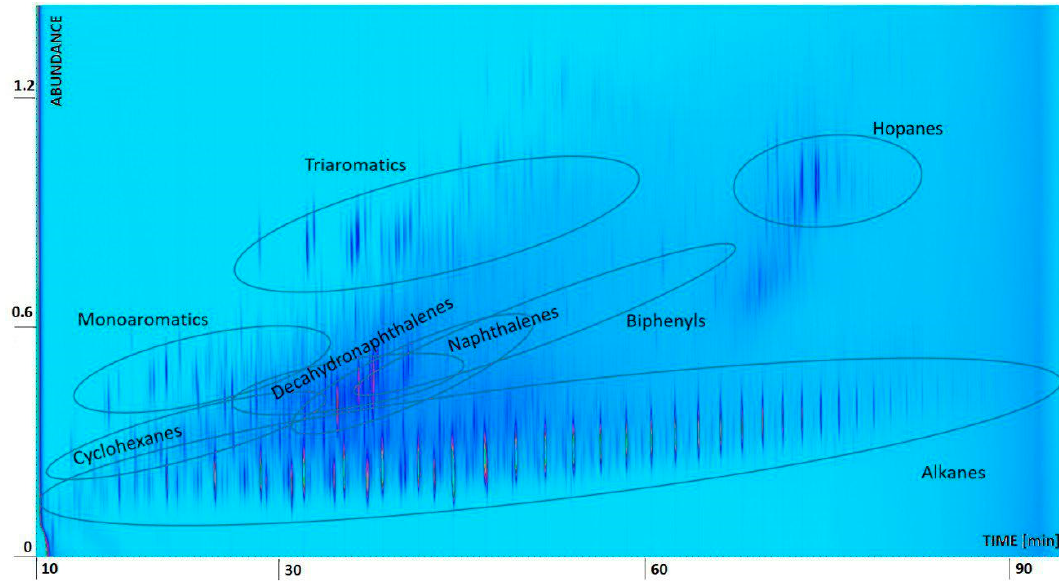
Materials 2019 , 12 , x FOR PEER REVIEW Figure 2. Comprehensive Two-dimensional Gas Chromatography (GC × GC) analysis of the oil.